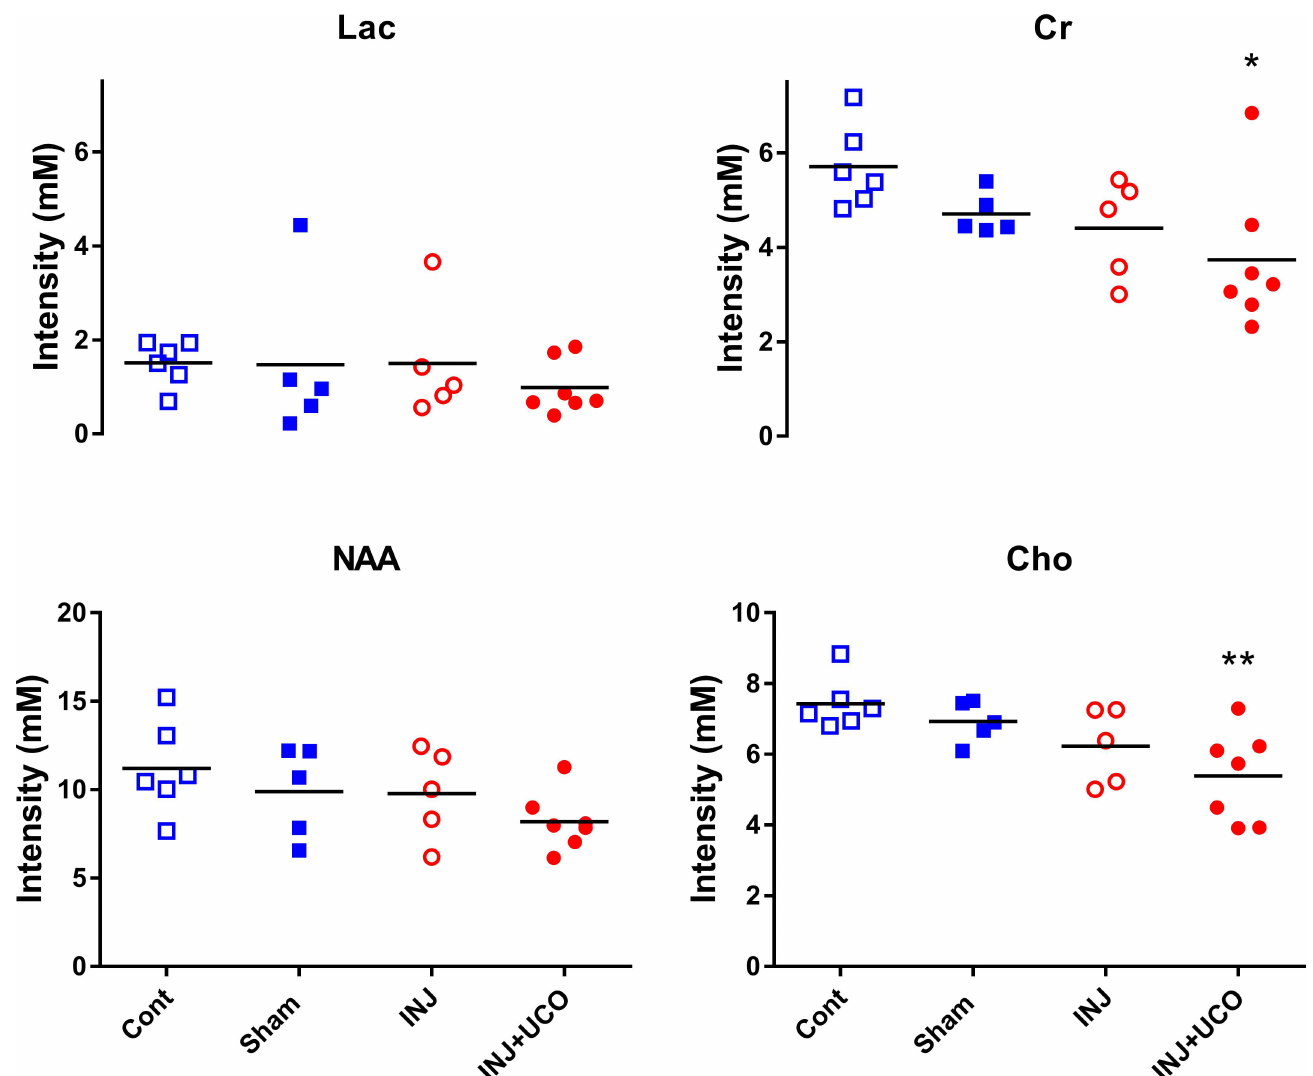
Fig 2. Absolute magnetic resonance spectroscopy (MRS) concentrations of metabolites in the preterm lamb brain. Individual absolute concentrations of lactate (Lac), creatine (Cr), choline(Cho), and N-acetylaspartate (NAA) using a single-voxel MRS encompassing supratentorial central white matter and deepgrey matter in the unoperatedcontrol (Cont; blue open squaresn = 6), sham surgery (Sham; blue closed squaresn = 5), injuriousventilation(INJ; red open circles n = 5), and INJ + umbilicalcord occlusion (INJ+UCO; red closed circles n = 7) groups. One way ANOVA comparisons tests relative to the Cont group were used with P < 0.05was considered statistically significant. * P < 0.01, ** P < 0.001vs INJ+UCO.